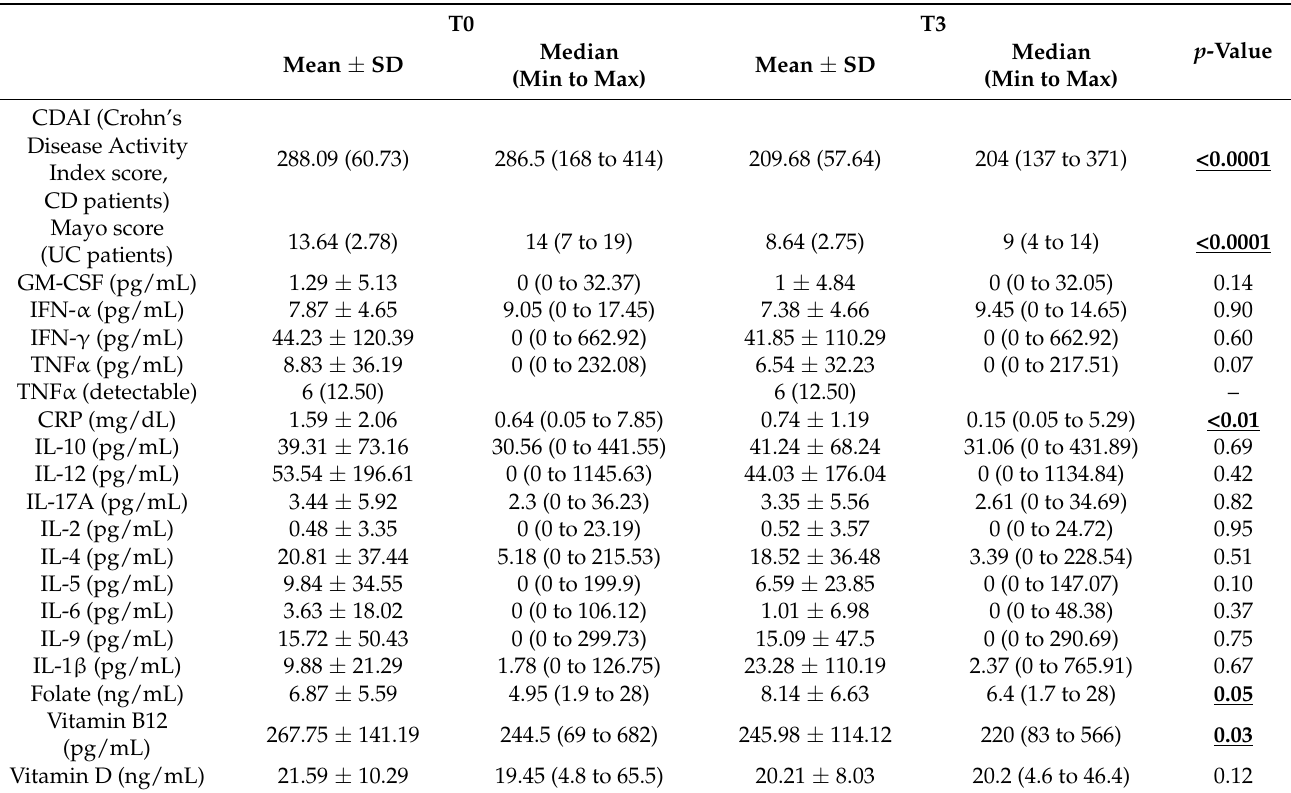
Table 2. Description of the whole sample across follow-up times (N:47). Statistically significant differences ( p -value ≤ 0.05) are underlined in